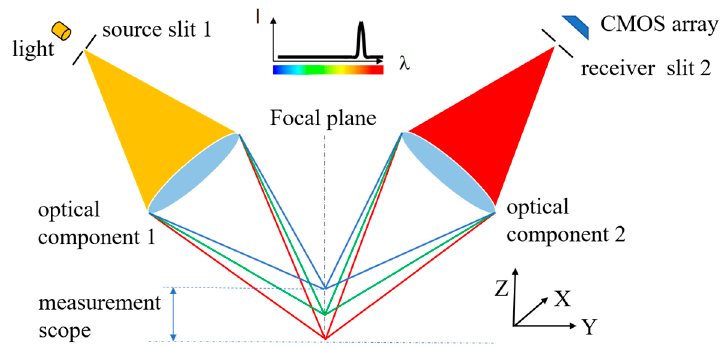
Figure 3. Schematic diagram of line-scanning chromatic confocal measurement.